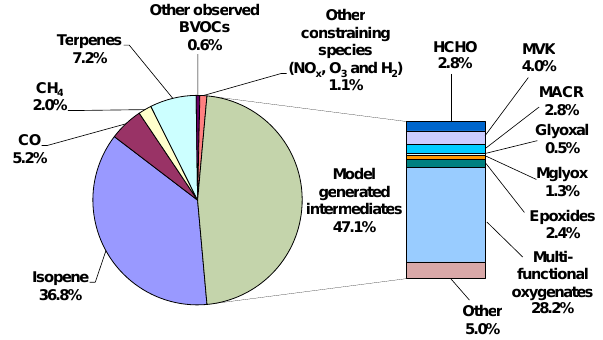
14: Percentage contributions towards the noon time calculated OH reactivity using a 24 h Fig. 14. Percentage contributions towards the noontime calculated lifetime with respect to physical loss of model generated species (solid red line in Fig. 11). The largest single contribution to the calculated OH reactivitycomes from isoprene, however the model calculated OH reactivity using a 24h lifetime with respect to physical loss of intermediates contribute a larger fraction toward the observed OH sink than isoprene and the observedterpenes combined. model generated species (solid red line in Fig. 11). The largest sin- gle contribution to the calculated OH reactivity comes from iso- Although current technology allows for some of these to be measured (for example MVK, prene, however the model calculated intermediates contribute a MACR, HCHO and some peroxides) the majority of the multi-functional model generated larger fraction toward the observed OH sink than isoprene and the intermediates are not readily amenable to current experimental techniques. However, if the observed terpenes